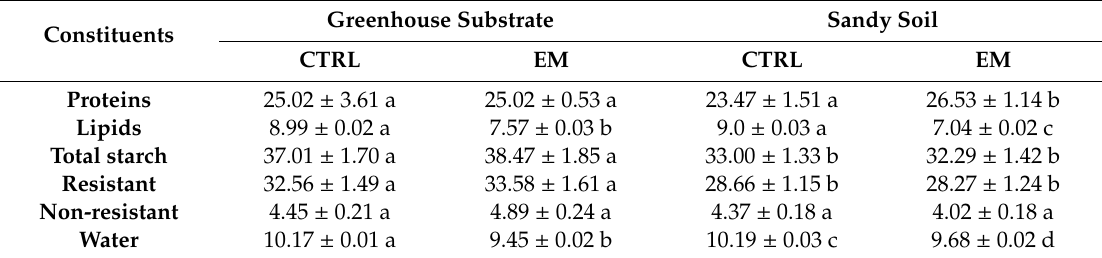
Table 1. Composition of seeds from bean plants grown in different soils, not treated or treated with EM. Data are expressed as g of nutrients per 100 g of dry seed matter. The water content of the sample is reported in the last row. In each row, values (mean ± SEM) with the same letters are not significantly different between treatments of the same substrate ( p ≤ 0.05).